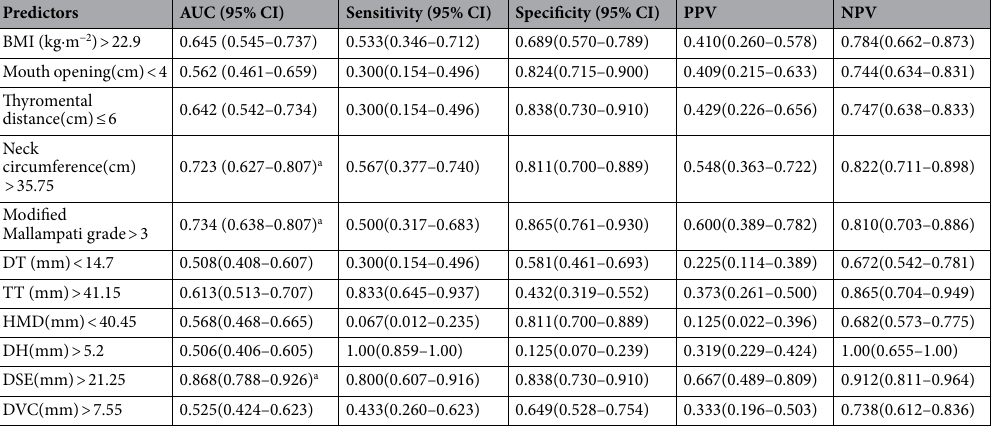
Table 4. Diagnostic validity profiles of effective predictors of DL. AUC area under the curve, PPV positive predictive value, NPV negative predictive value, BMI body mass index, DT distance from skin to under surface of tongue, TT thickness of the thickest part of tongue body, HMD hyoid mental distance, DH depth of hyoid, WH width of hyoid, DSE distance from skin to epiglottis, DVC depth of the anterior combination of the vocal cords. a AUC > 0.7 means that diagnostic value is high.